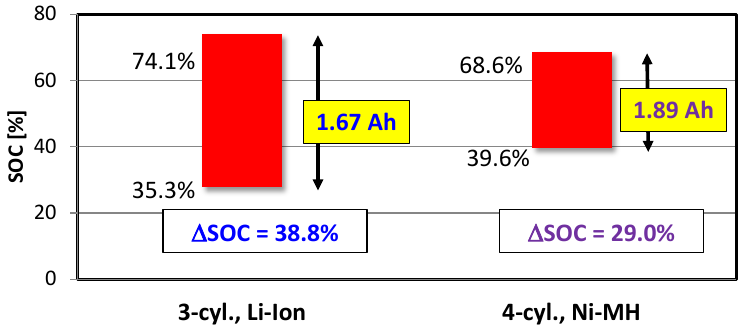
Figure 5. SOC variation ranges of the analyzed batteries.